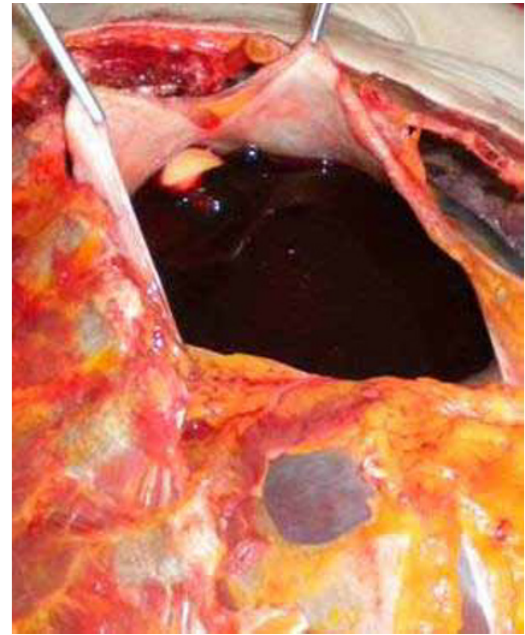
Figure 1. Presentation of haemopericardium at the opening of the pericardial cable.